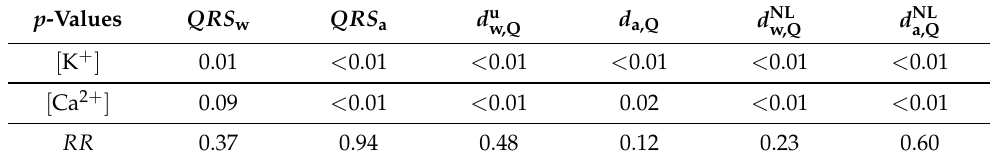
Table 2. p -values from the parametric test ( t -test) to evaluate statistical significance of non-zero mean Fisher z-transformed Pearson correlation coefficients between QRS markers and [ K + ] , [ Ca 2 + ] and RR. p -Values QRS w QRS